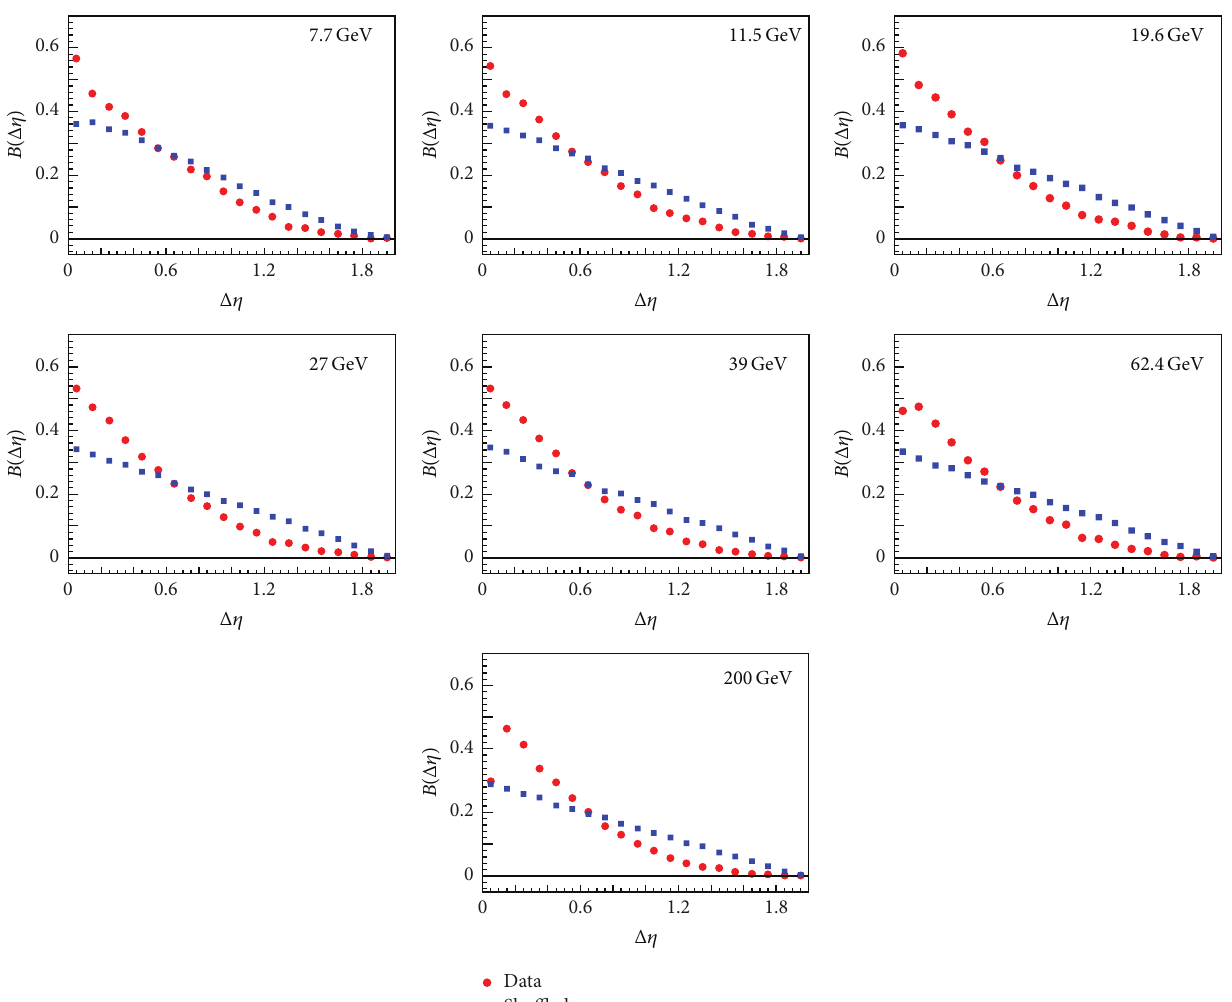
Figure 5: The balance functions in terms of Δ𝜂 for all charged particles. Central events (0–5%) are shown here at √𝑠 200 GeV. The graph is taken from